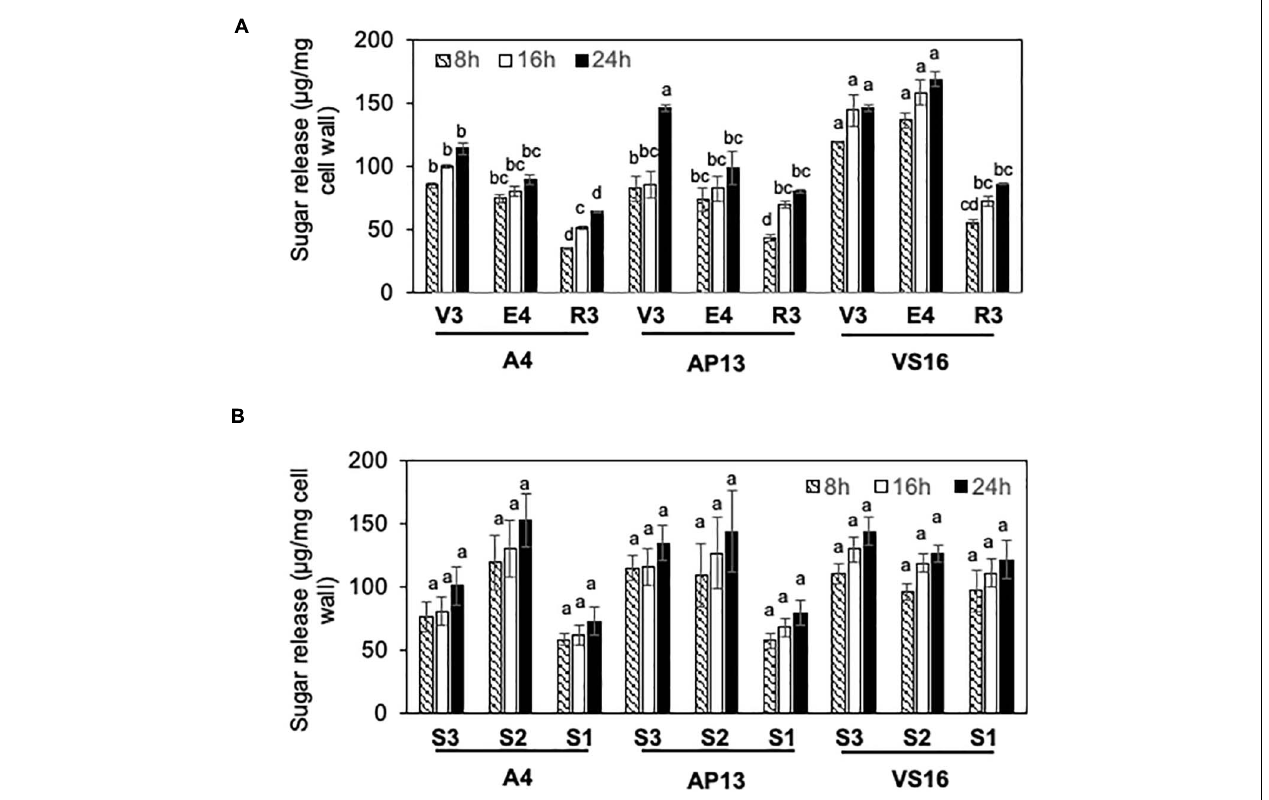
FIGURE 4 | Enzymatic digestibility (ED) of switchgrass genotypes, A4, AP13, and VS16. Samples are diagramed in Figure 1 and are arranged from young to old stages/segments. (A) Whole tillers at V3, E4, and R3 developmental stages and (B) S3, S2, and S1 tissue segments of the E4 tiller as shown in Figure 1 . Cell wall residues from different tissue samples were subjected to enzymatic hydrolysis, and the amount of sugars released after 8, 16, and 24 h of incubation were quantified via DNS assay. Error bars indicate standard error ( n = 3). Means with unshared letters are likely to be significantly different [Tukey’s honestly significant difference (HSD), P ≤